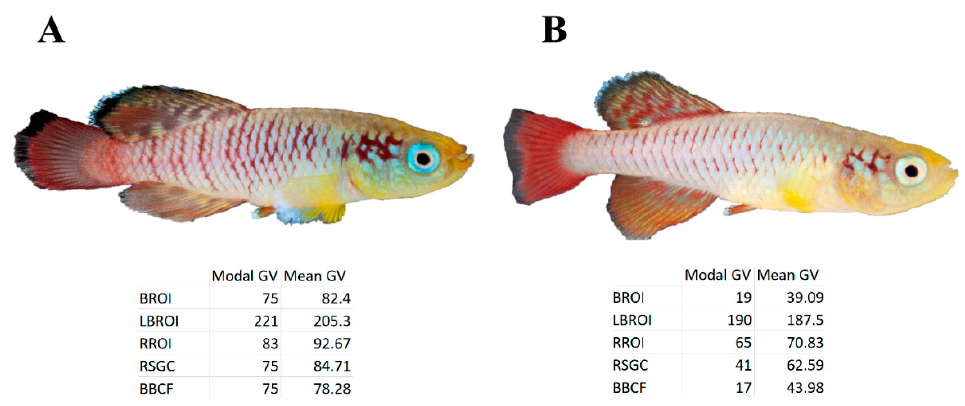
Figure 7. A comparison of the coloration of various male N. guentheri of comparable ages and sizes according to the gray value of the studied zones. ( A ) N. guentheri male with typical coloration and size. ( B ) Male with deviant type of coloration.